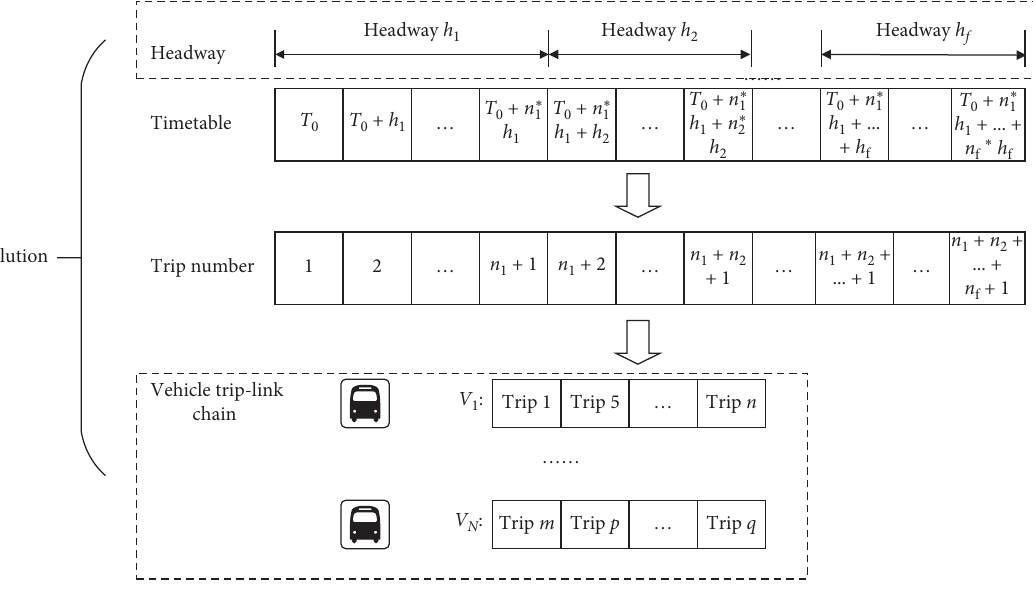
Figure 3: Schematic diagram of solution